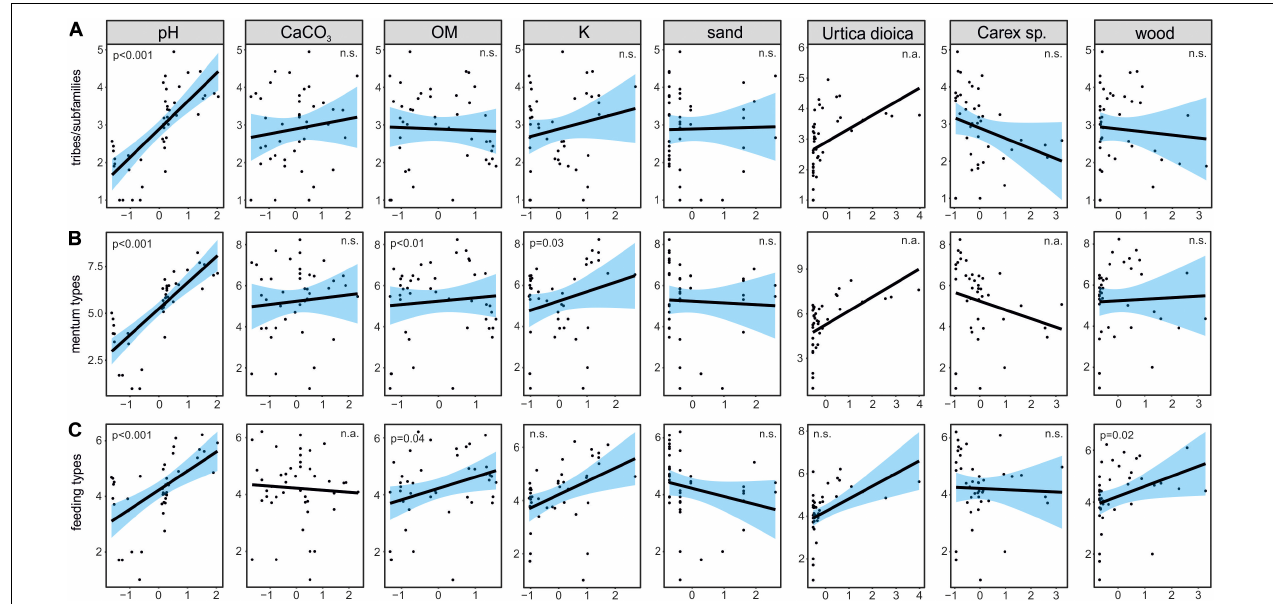
FIGURE 5 | Visualization of generalized linear models testing for effects of selected environmental factors on richness of chironomid tribes/subfamilies (A) , mentum types (B) and feeding type (C) , where “n.a.” means that the factor was not included in the models, and “n.s.” that its explanatory power was not significant.